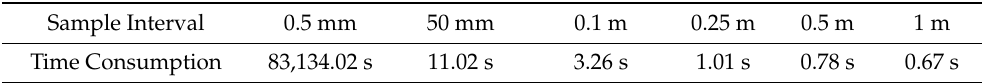
Table 2. Time Consumption for Different Sample